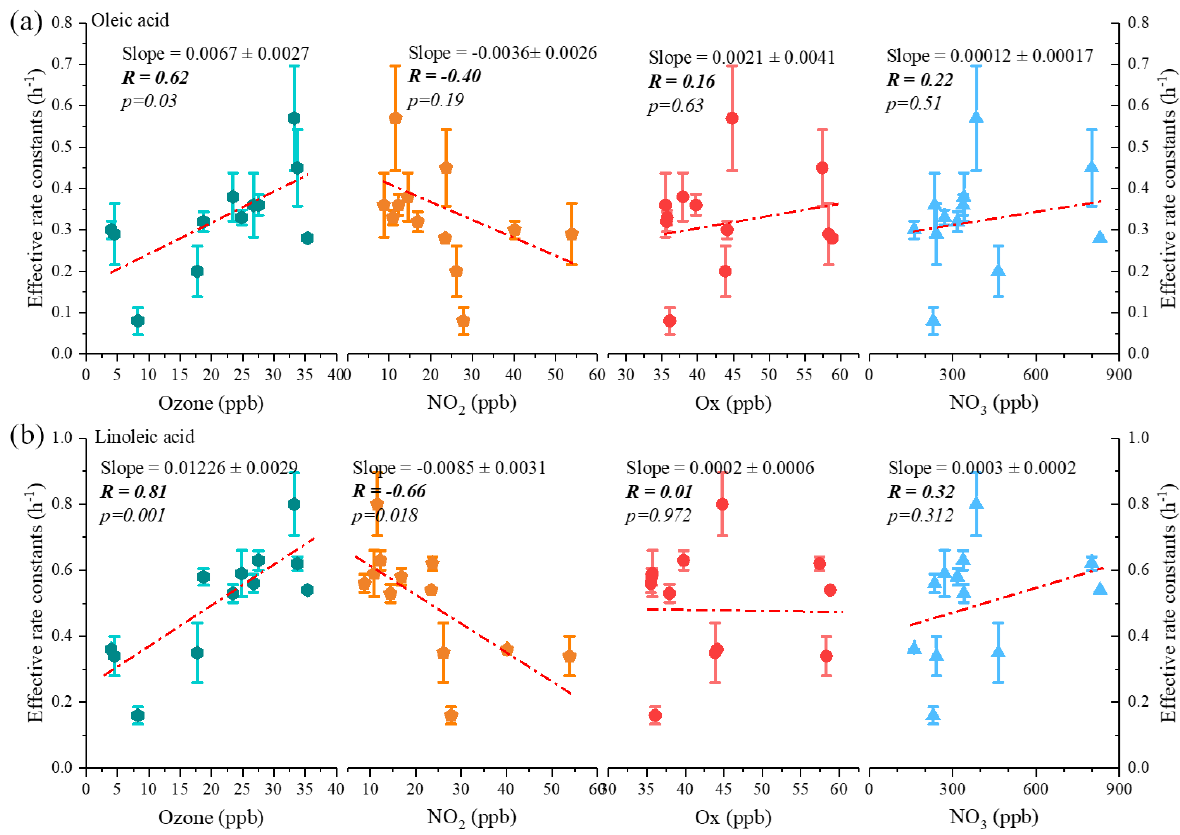
Figure 9. Correlations of the estimated effective decay rate constant with average nighttime atmospheric oxidant concentrations for oleic acid (a) and linoleic acid (b) (the p value indicates the parameter of the F test of the regression equation in the regression model).